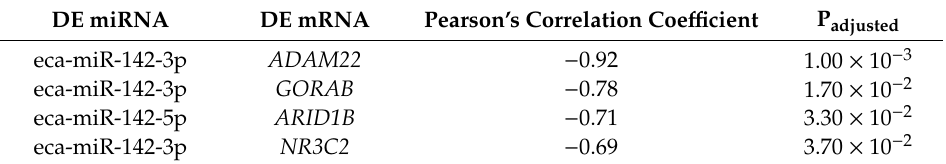
of asthmatic horses in remission and control horses. Pearson’s correlation coe ffi cient and adjusted p -values are indicated.